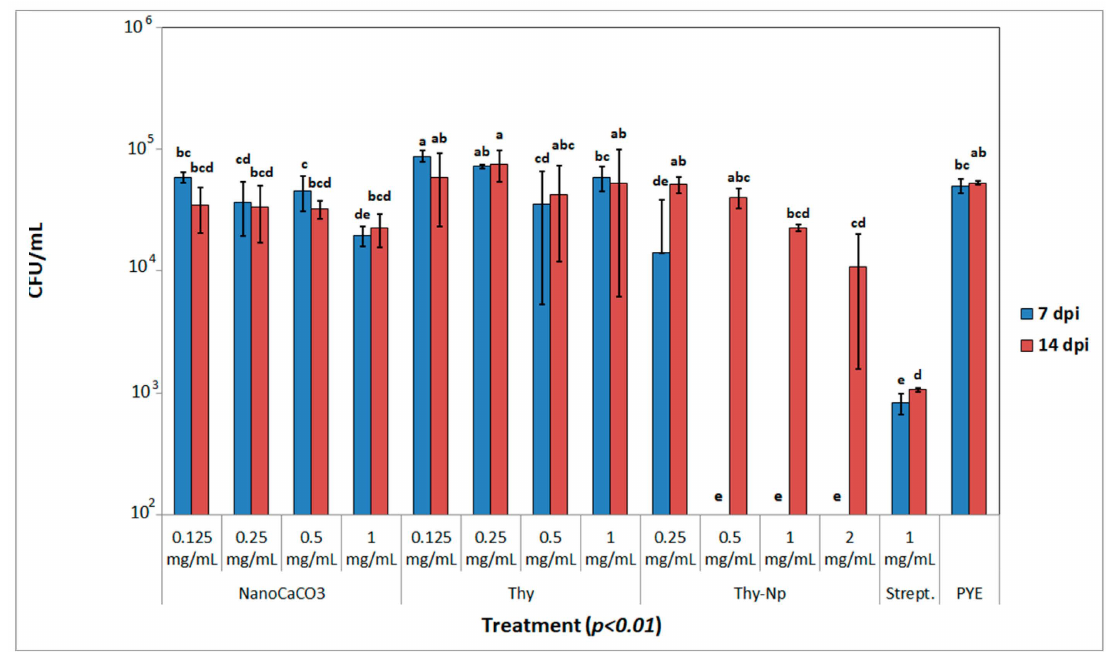
Figure 4. In vitro growth test data (CFU/mL) on XfDD at seven and fourteen days post-inoculation (dpi), following treatment with NanoCaCO 3 , Thy and Thy-Np at different concentrations (range 0.125–2 mg/mL). Streptomycin at 1 mg/mL and PYE broth alone were used as controls. Different letters refer to statistical differences among the treatments after one way analysis of variance (ANOVA), which was performed on the means at each time point. Data are represented as means ± standard deviation. The experiment was repeated twice. No differences among the results of the two independent experiments were noted. The most promising results in terms of growth inhibition were showed by Thy-Np when used, starting from 0.25 mg/mL at 7 dpi. Thy and nanoCaCO 3 had just a slight